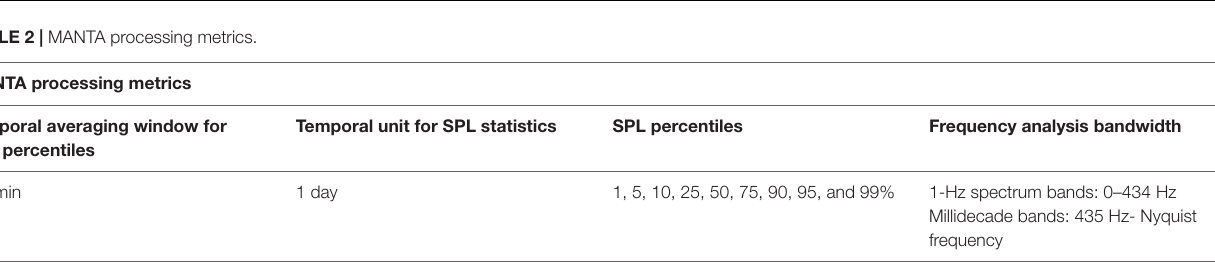
TABLE 2 | MANTA processing